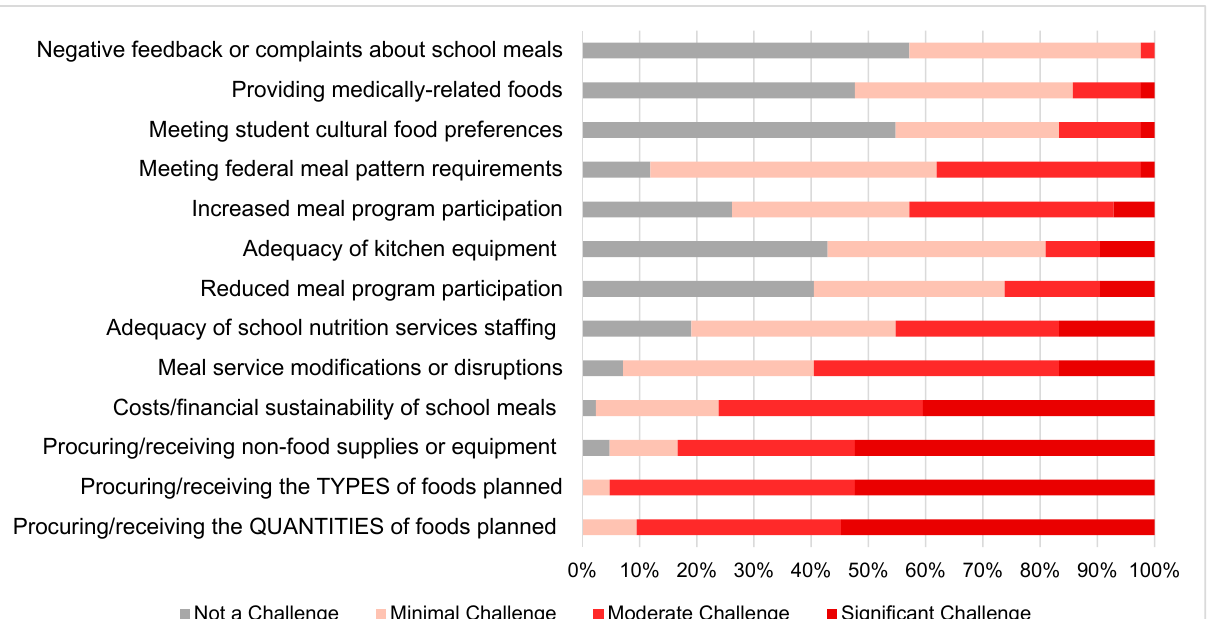
plannedProcuring/receiving Procuring/receiving the TYPES of foods Procuring/receiving the QUANTITIES of foods planned 0% 10% 20% 30% 40% 50% 60% 70% 80% 90% 100% Figure 1. Perceived Challenges Related to the COVID-19 Pandemic among School Food Authorities in Maine (n = 43). Figure 1. Perceived Challenges Related to the COVID-19 Pandemic among School Food Authorities in Maine ( n = 43).